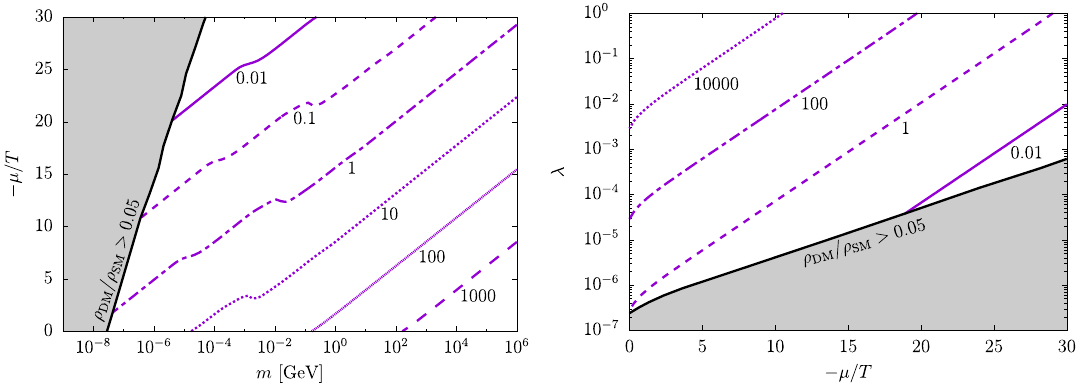
Figure 9 . Left: parameter space consistent with the correct relic density for dark matter in kinetic equilibrium. The curves are labeled by ξ = T SM /T . Both ξ and µ/T are fixed in the relativistic regime ( T = 10 m ). In the excluded area, the energy density of relativistic DM exceeds 5% of that of the SM radiation. Right: minimal self-coupling required for kinetic equilibrium as a function of µ/T for m = 1